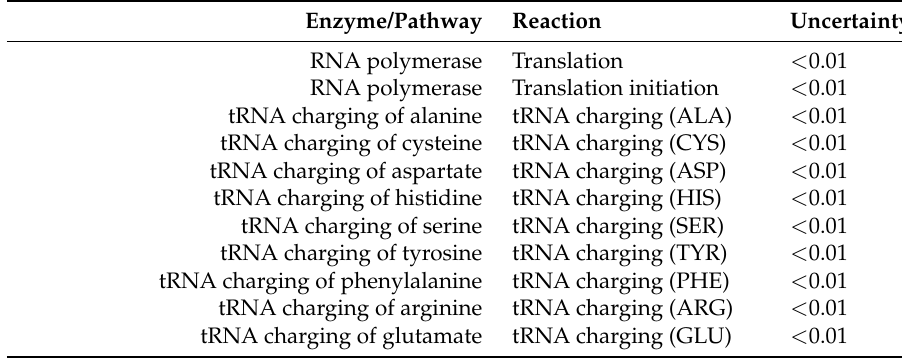
Table 2. Flux uncertainty calculated using flux variability analysis for the base synthetic dataset during the first production phase (0 h to 1.5 h), normalized to the glucose consumption rate. Enzyme/Pathway Reaction